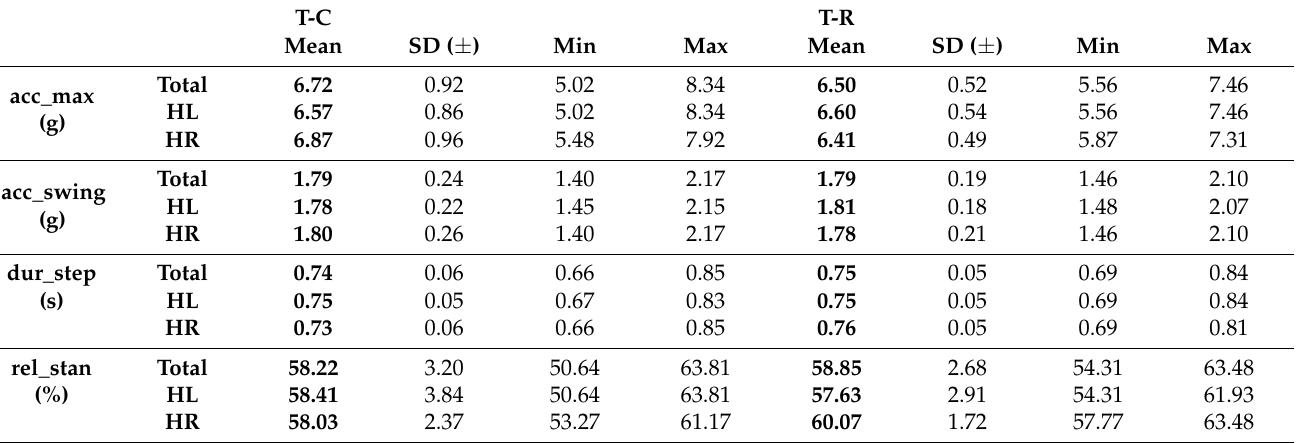
Table 5. Mean IMU data for ten dairy cows in total and differentiated between left (HL) and right hind limb (HR) during trot on concrete (T-C) and rubber mats